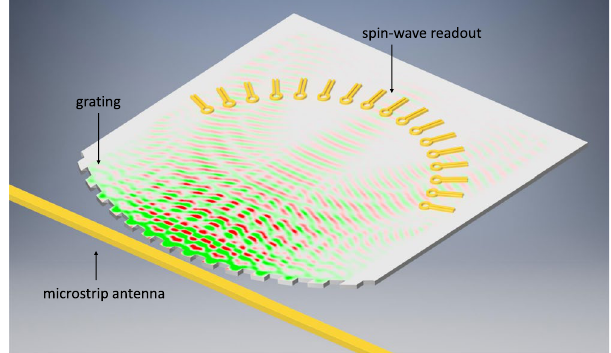
Figure 1. Schematic layout of the proposed spin-wave-based spectrum analyzer. The input signal is injected into a microstrip antenna, which generates spin waves on the patterned edge of an adjacent magnetic film. The interference pattern created by the spin waves is read out at specific locations using nanoscale loop antennas. The interference pattern is created in a way so that the frequency components of the input signal will become separated spatially.